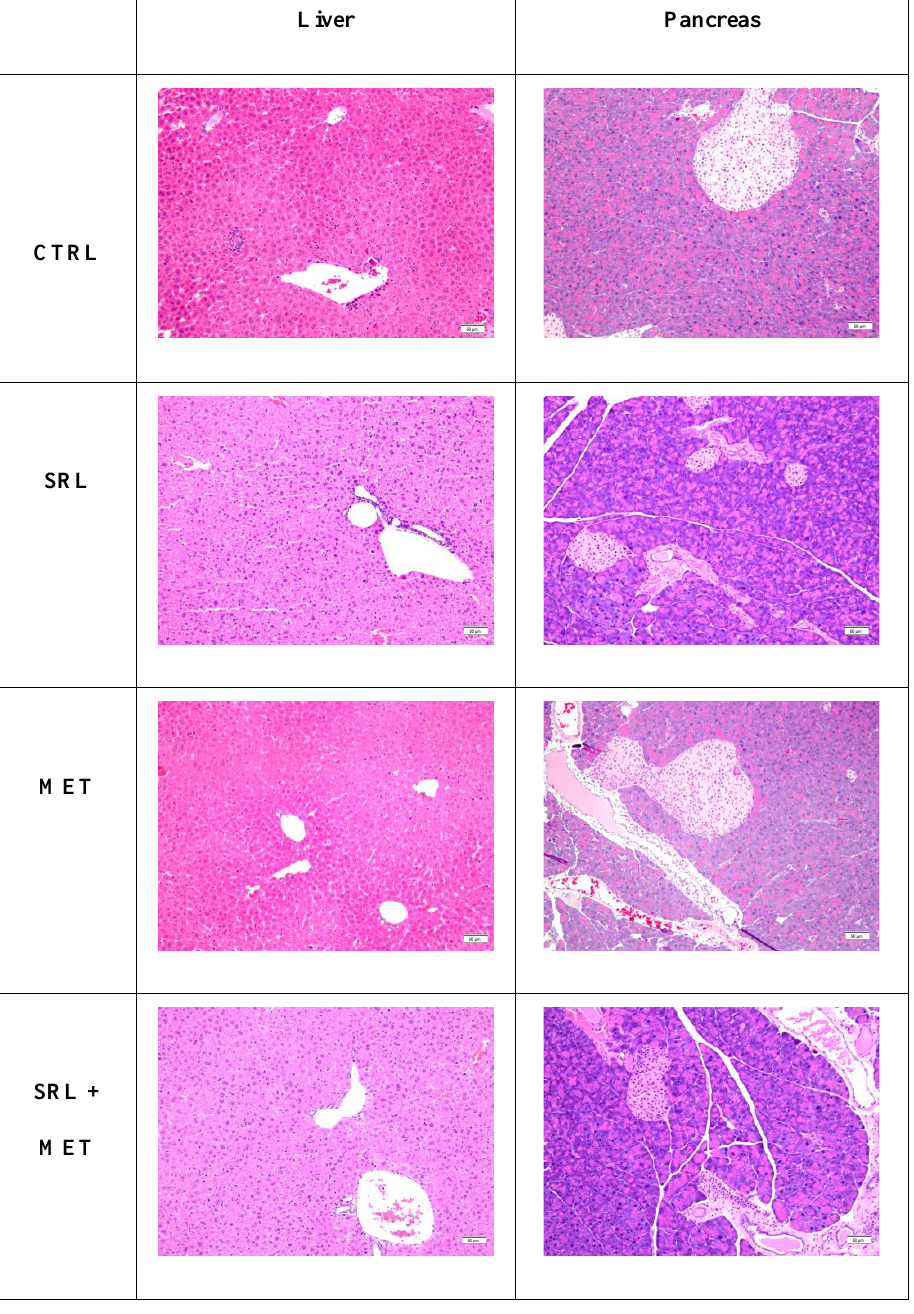
Figure 7. Representative histology of the liver and pancreas in mice untreated and mice treated with water (CTRL), 5 µg/g of SRL alone, 200 µg/g of MET alone and SRL+MET cotreatment. Liver architecture is preserved and hepatocytes are intact with the absence of vacuolization, apoptosis, and parenchymal inflammation (hematoxylin and eosin, 20x). The pancreas also reveals intact exocrine glands and islet cells in all studied groups (hematoxylin and eosin,